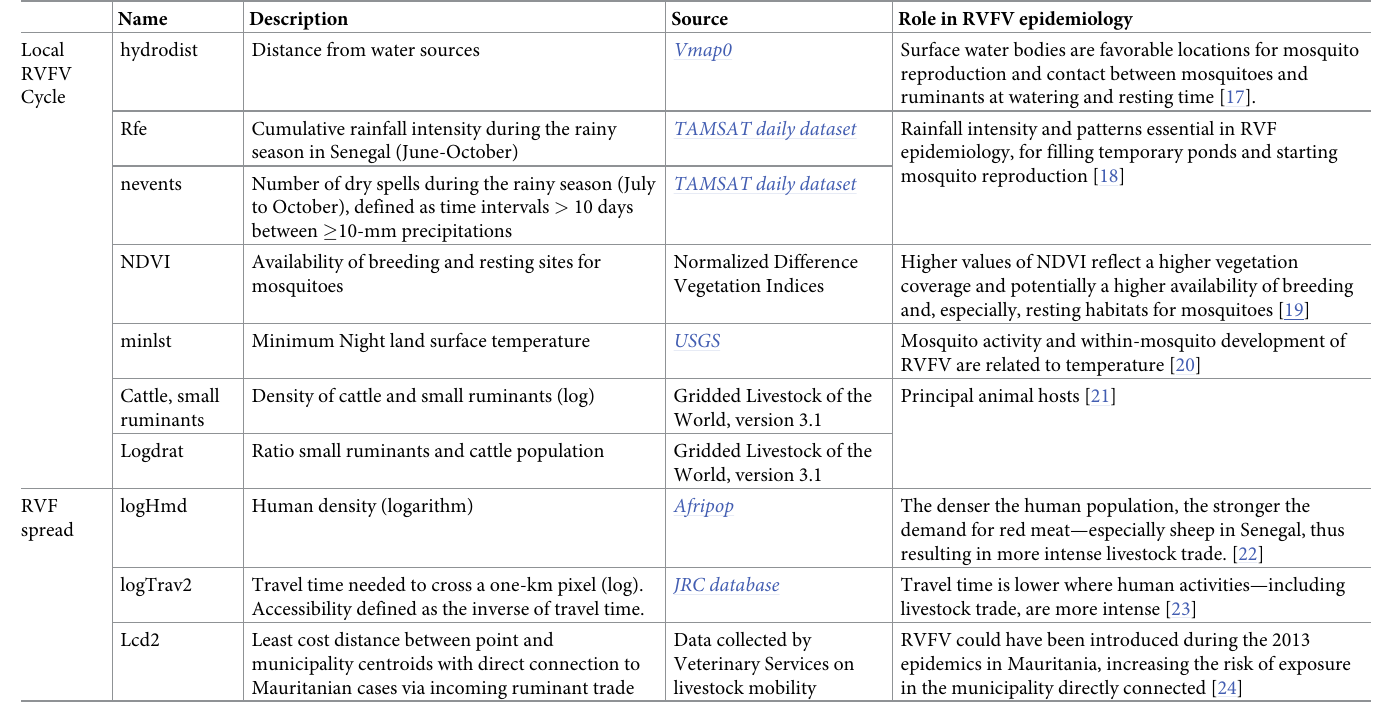
Table 1. Predictors of RVFV transmission and